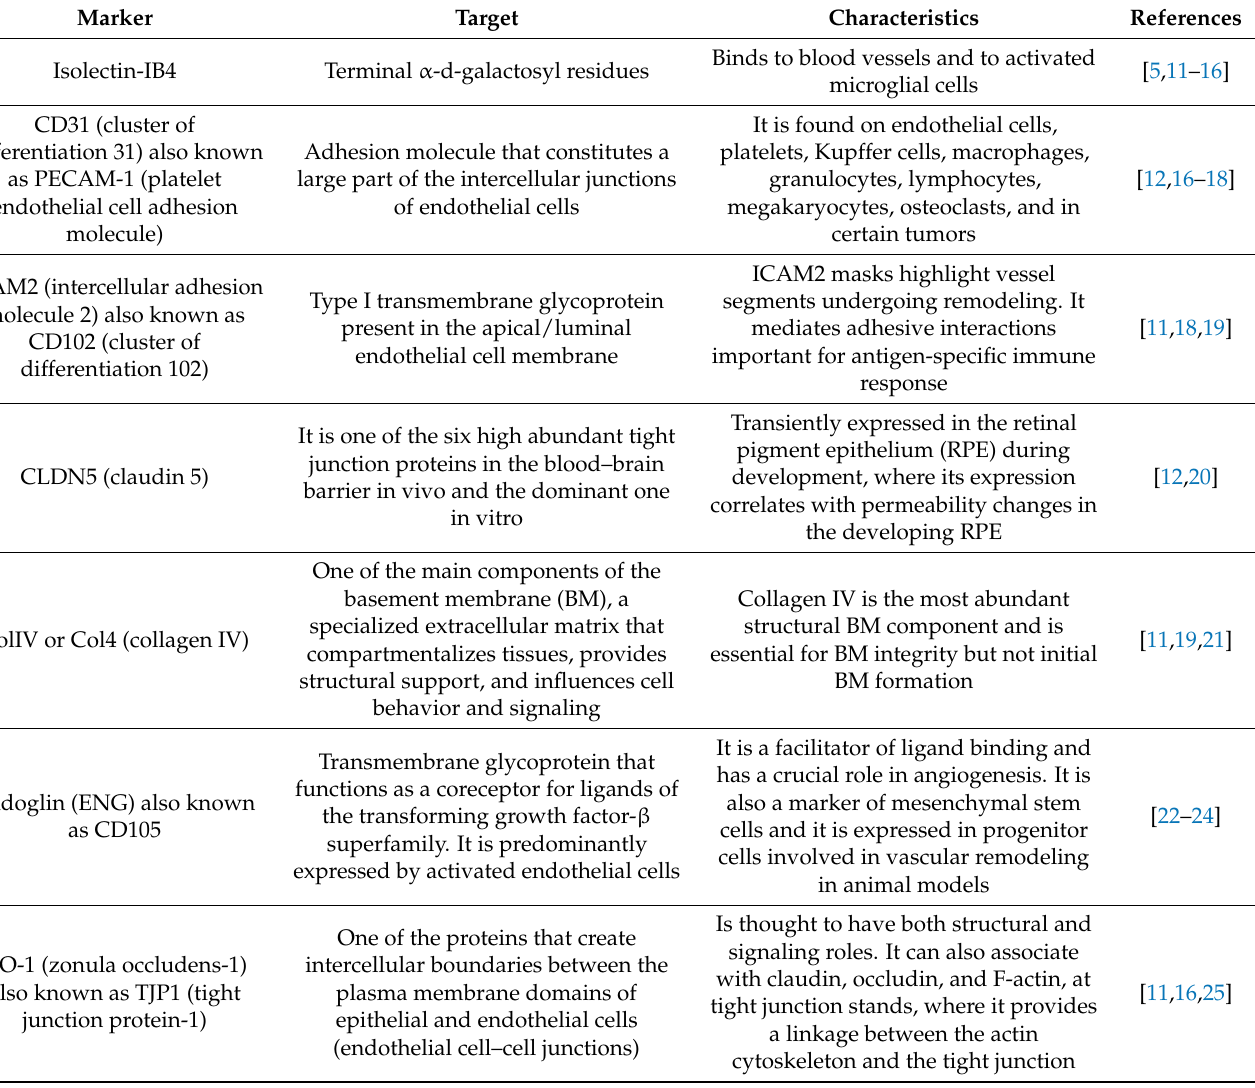
Table 1. Markers to identify mouse blood